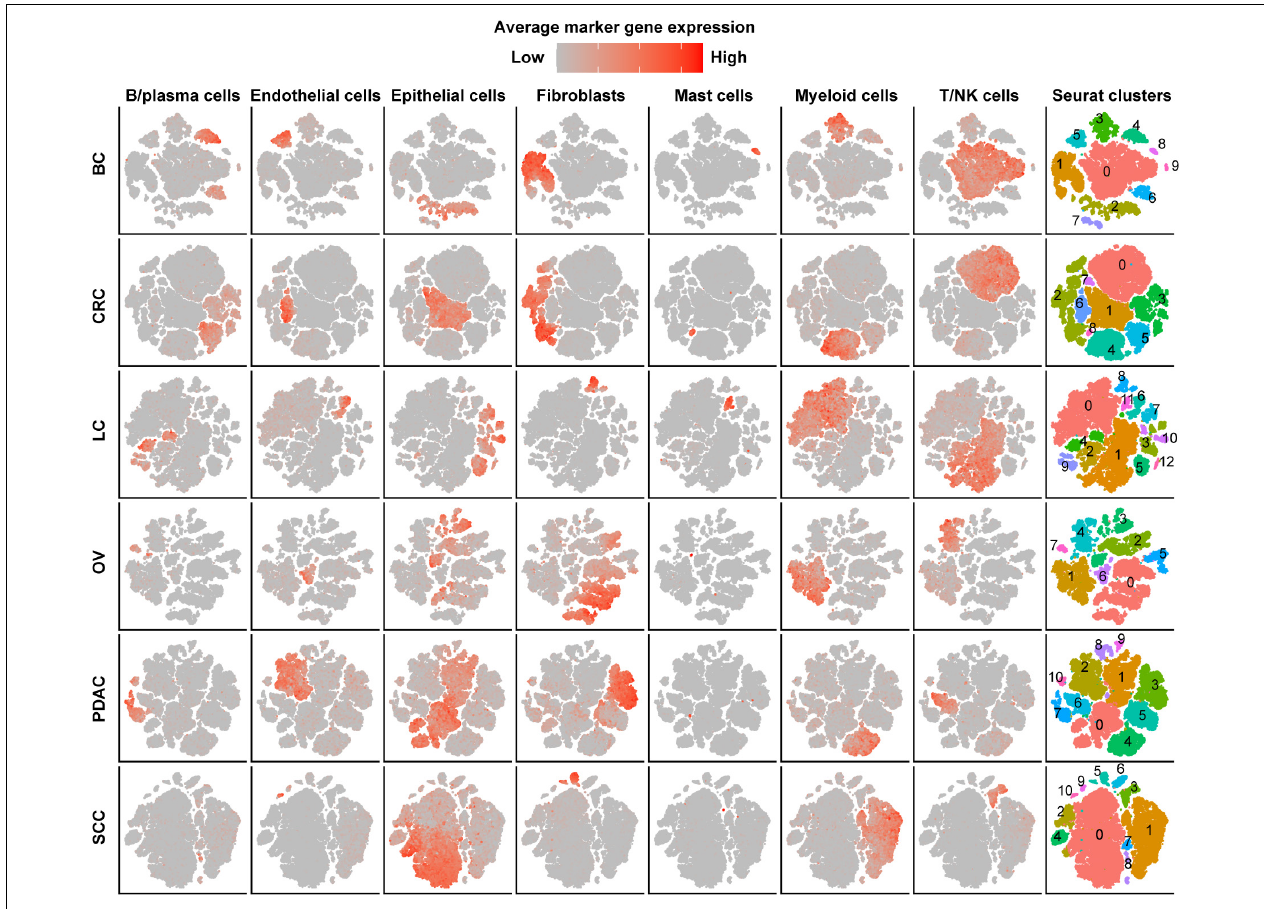
FIGURE 1 | Cell-type identification in pan-cancer. t-SNE map of single cells from cancer tissues to visualize cell-type clusters based on the expression of known marker genes [T/NK cells ( CD2 , CD3D , CD3E , CD3G , FGFBP2 , XCL1 , FCGR3A , KLRD1 , and KLRF1 ), fibroblasts ( FAP , PDPN , COL1A2 , DCN , COL3A1 , COL6A1 , and LUM ), myeloid cells ( CD14 , CD16 , and CD68 ), mast cells ( CMA1 , MS4A2 , TPSAB1 , TPSB2 , and CPA3 ), endothelial cells ( PECAM1 , VWF , ENG , PLVAP , and SELE ), B/plasma cells ( SLAMF7 , CD79A , BLNK , FCRL5 , and CD79A ), and epithelial cells ( EPCAM , KRT19 , KRT7 , KRT18 , KRT1 , DMKN , and KRT6C